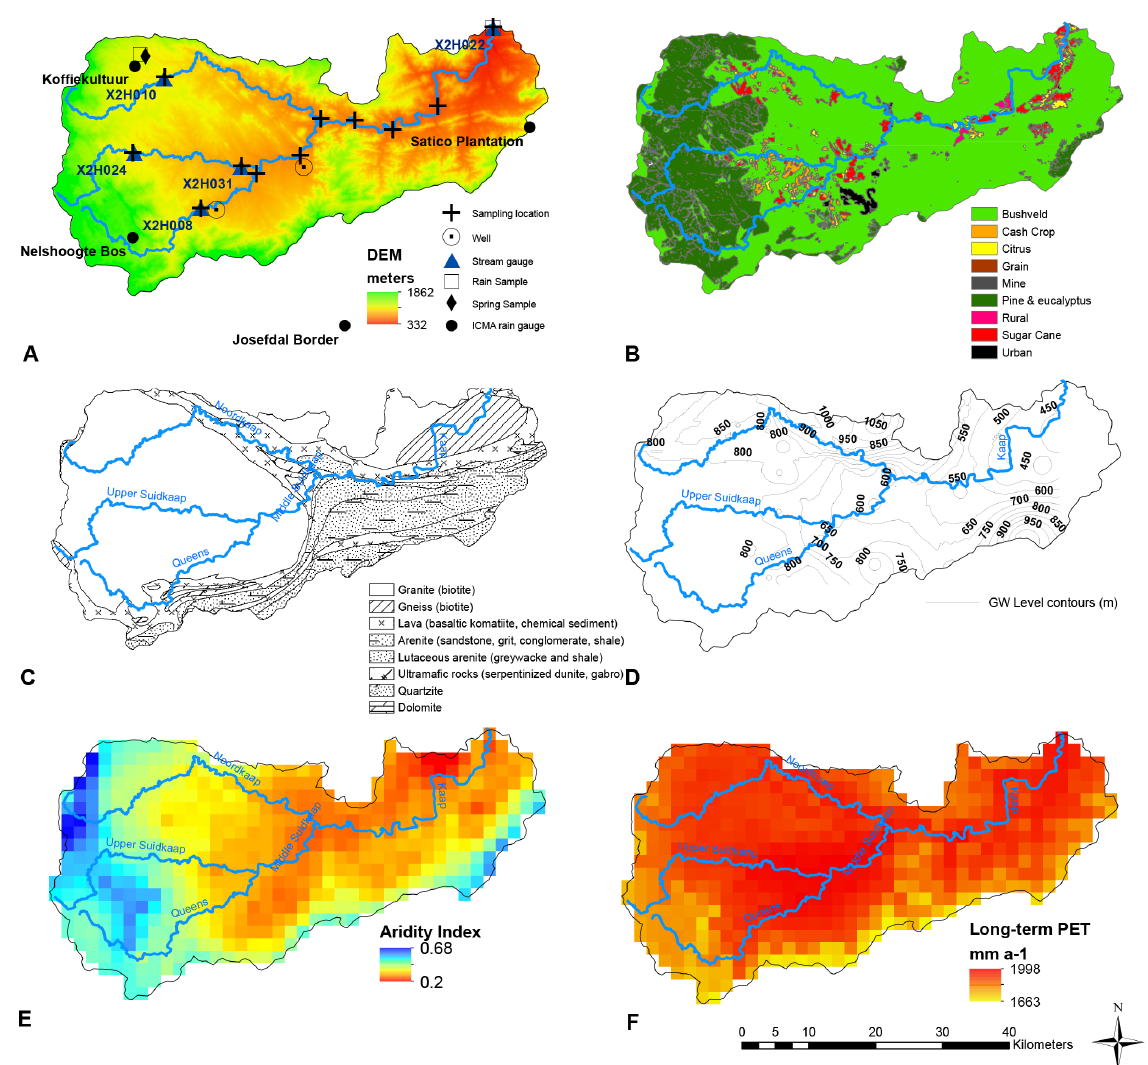
Figure 2. (a) Digital elevation model (DEM) of the Kaap catchment with sampling locations and stream and rain gauge locations, (b) land use map, (c) geological map, (d) contour map of static groundwater levels, (e) aridity index ( < 0.03 hyper arid, 0.03–0.2 arid, 0.2–0.5